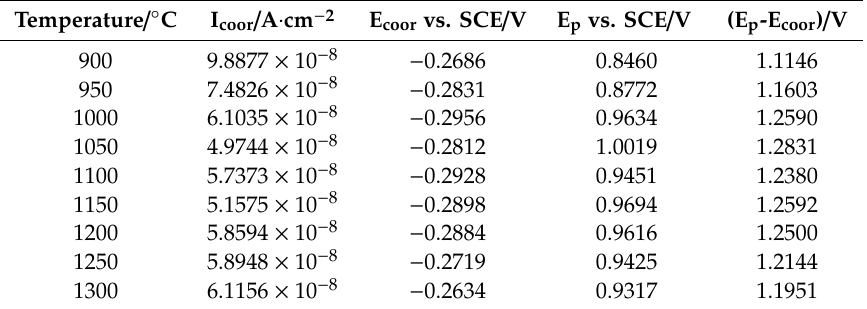
Table 2. The electrochemical parameters for UNS S32750 super duplex stainless steel (SDSS) after solution treatment at di ff erent temperature. I coor : corrosion current density, E corr : corrosion potential, E p : pitting potential. SCE, saturated calomel